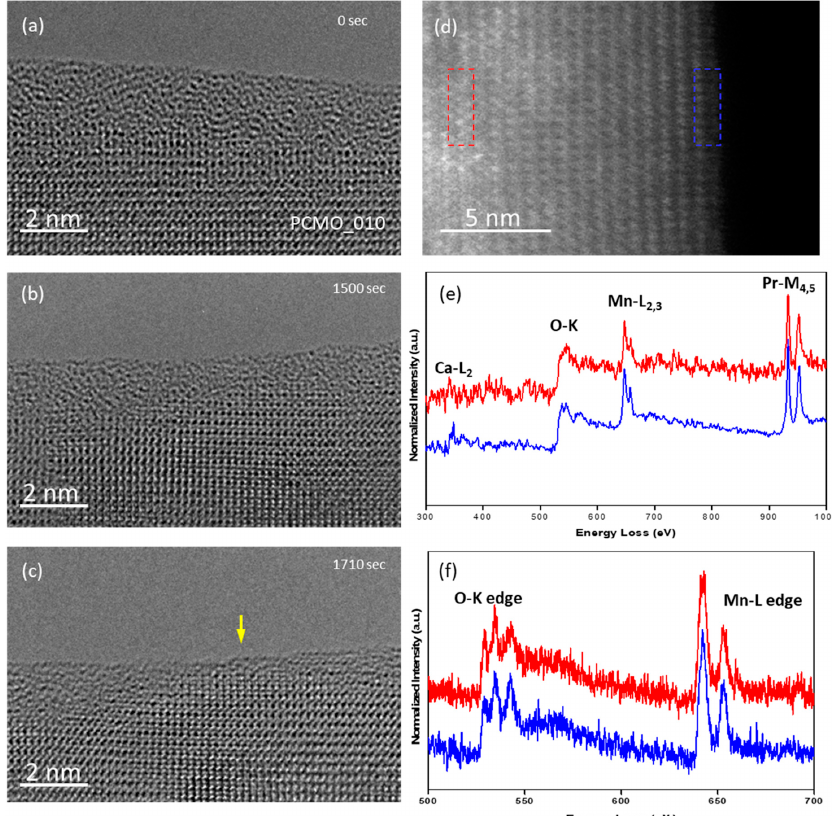
Figure 7. ( a )–( c ) HRTEM mages showing transformation of amorphous edge into crystalline for the PCMO (x = 0.1) in He gas at pressure of 50 ubar. The first crystalline facets (marked with the yellow arrow in b) start to appear after ~28 min (1710 s). ( d ) High-angle annular dark field (HAADF) image of the recrystallized area. ( e ) EELS spectra (1 eV/channel) demonstrate the presence of Pr, Ca,